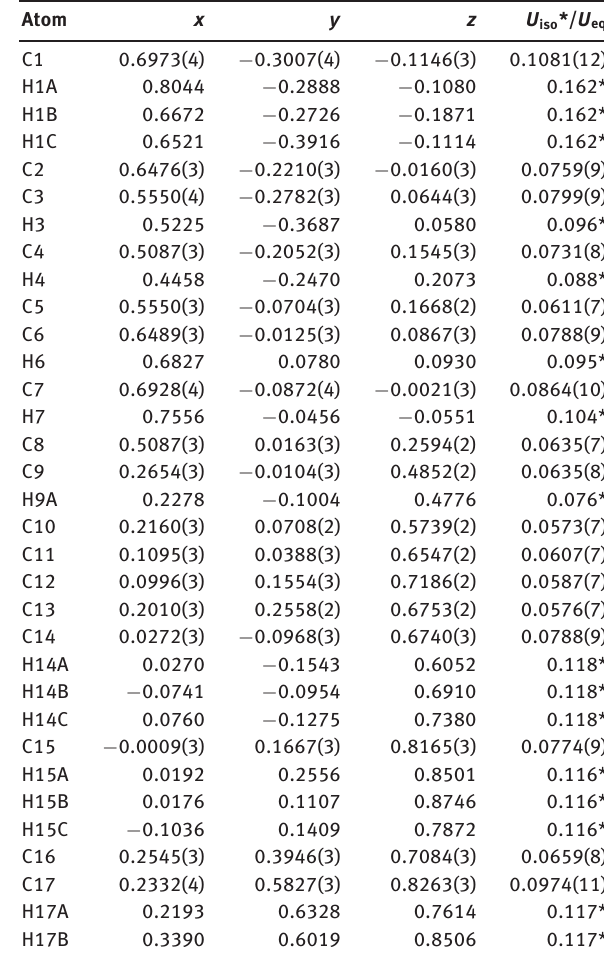
Table 2: Fractional atomic coordinates and isotropic or equivalent isotropic displacement parameters (Å 2